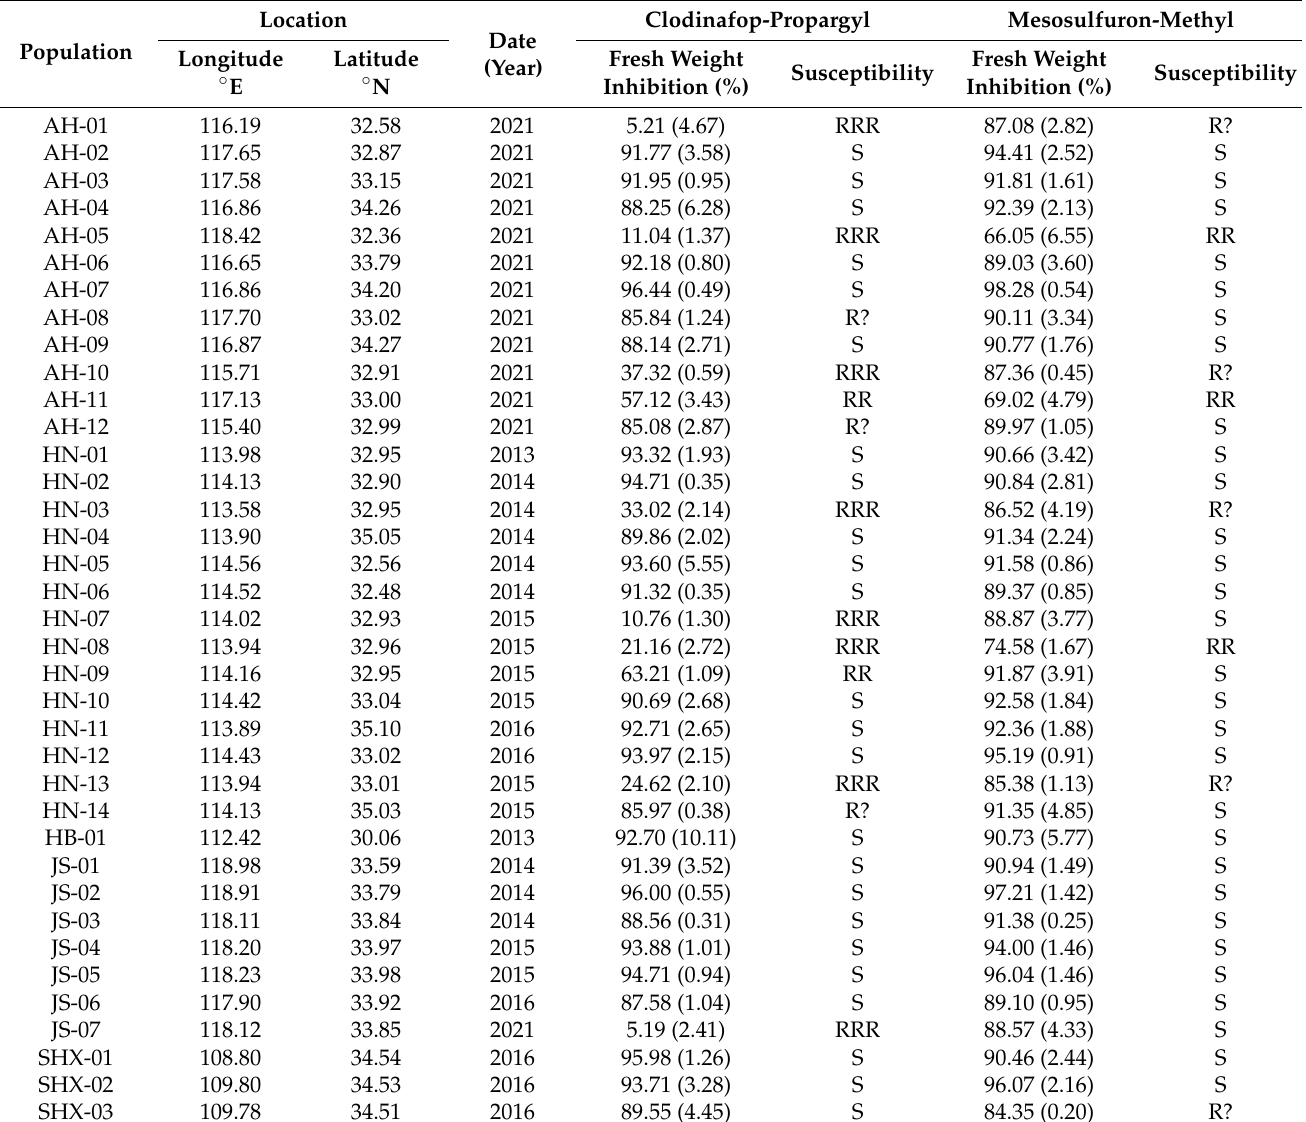
Table 1. Information on the L. multiflorum seeds collected in this study and the susceptibility of different L. multiflorum populations to clodinafop-propargyl and